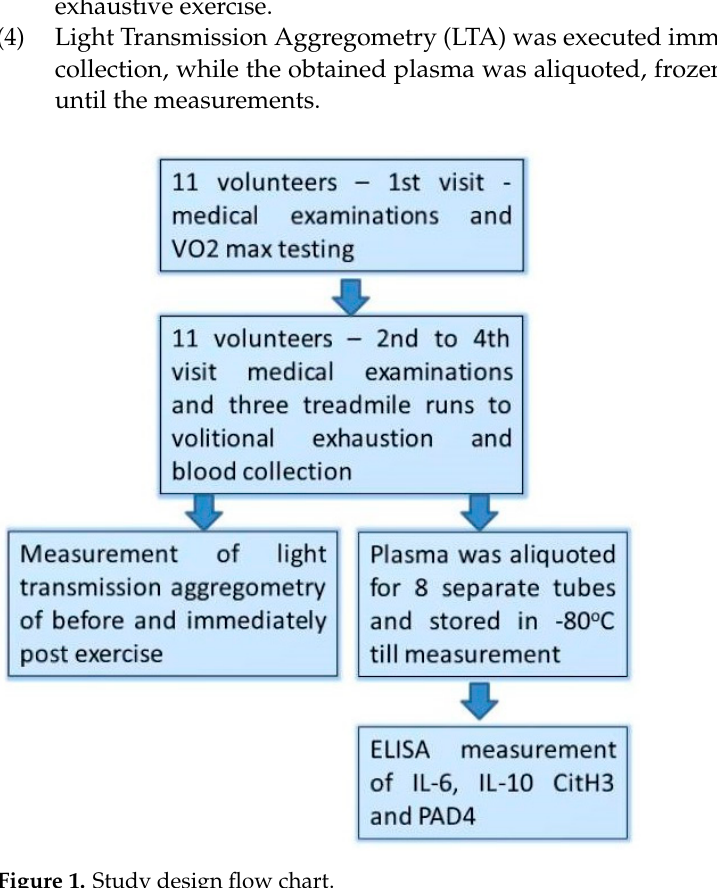
Figure 1. Study design flow chart. 113